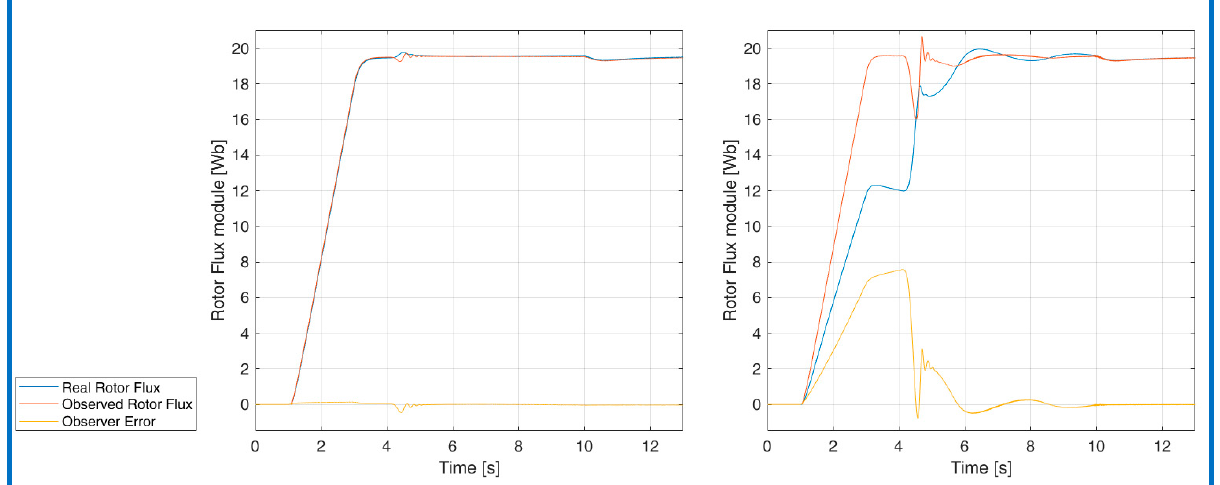
Figure 10. Real rotor flux module (blue), observed rotor flux module (red), and observer error (yellow), with ideal generators (left) and with inverter (right).